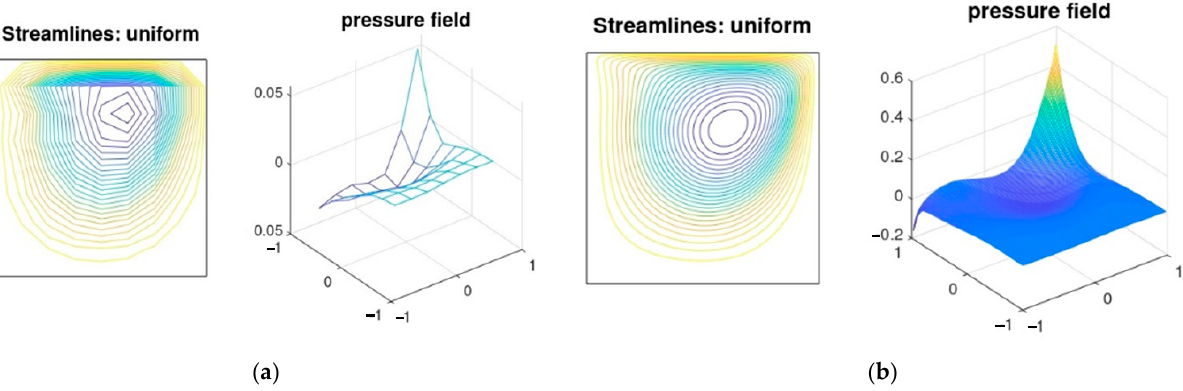
Figure 3. Equally distributed streamline plot associated with a 16 × 16 and 256 × 256 square grid, 𝑄 (cid:2869) –𝑃 (cid:2868) approximation. ( a ) 16 × 16 elements; ( b ) 256 × 256 elements.